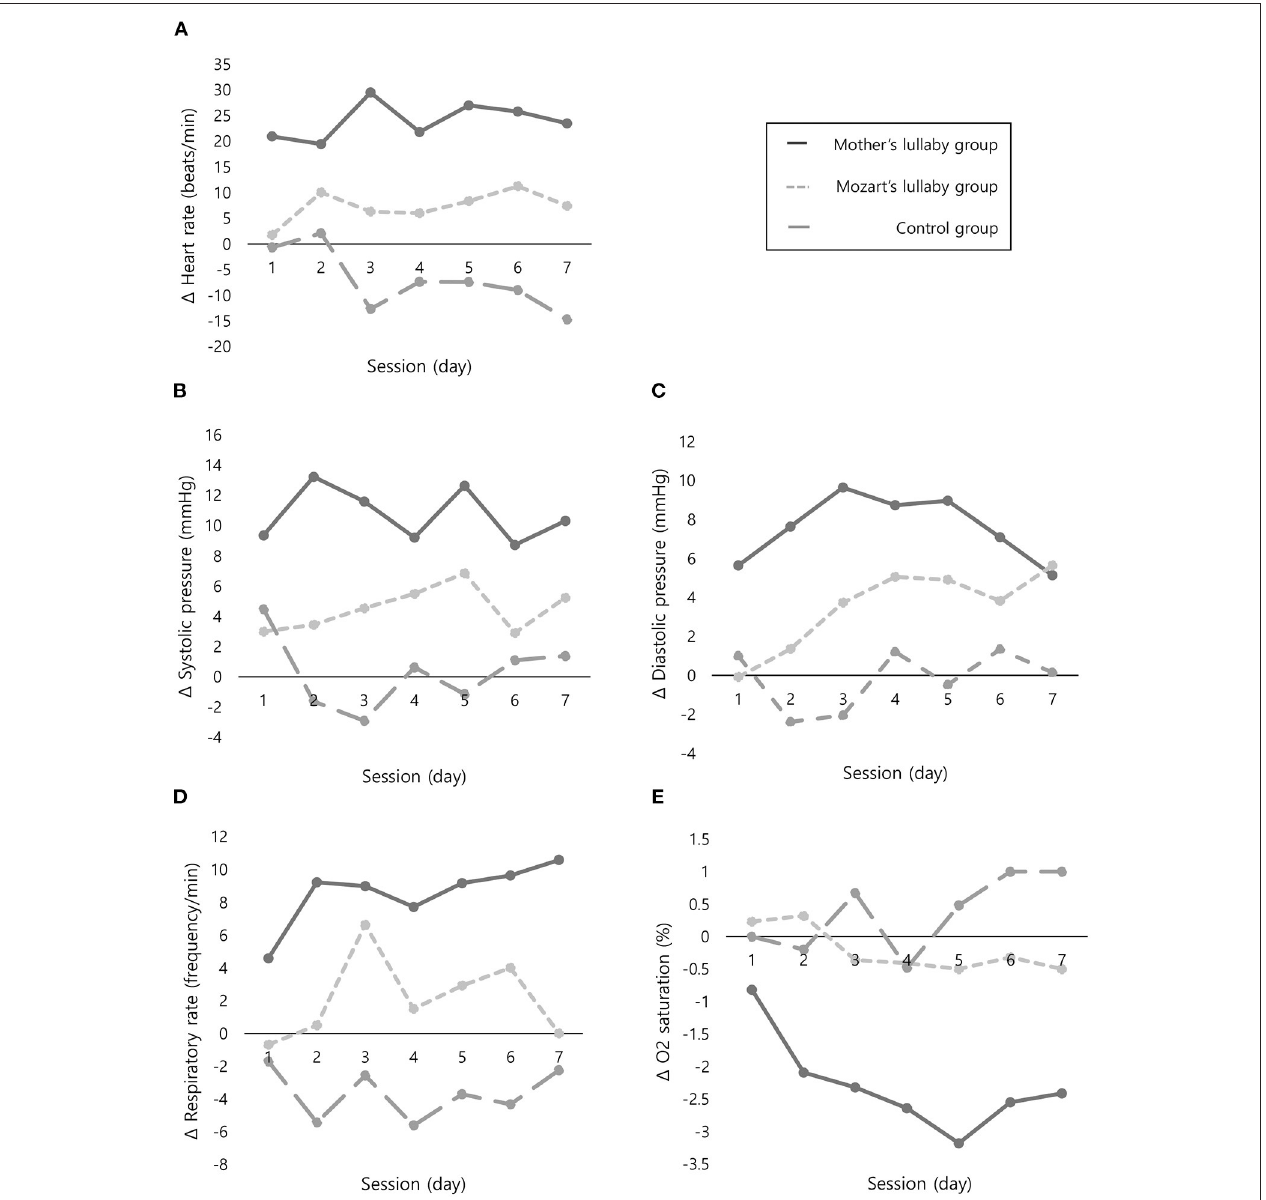
FIGURE 2 | Comparison of changes in physiological parameters before and after intervention between the three groups. (A) Mean difference in heart rate. (B) Mean difference in systolic pressure. (C) Mean difference in diastolic pressure. (D) Mean difference in respiratory rate. (E) Mean difference in O 2 saturation. 1 , Mean difference of before and after